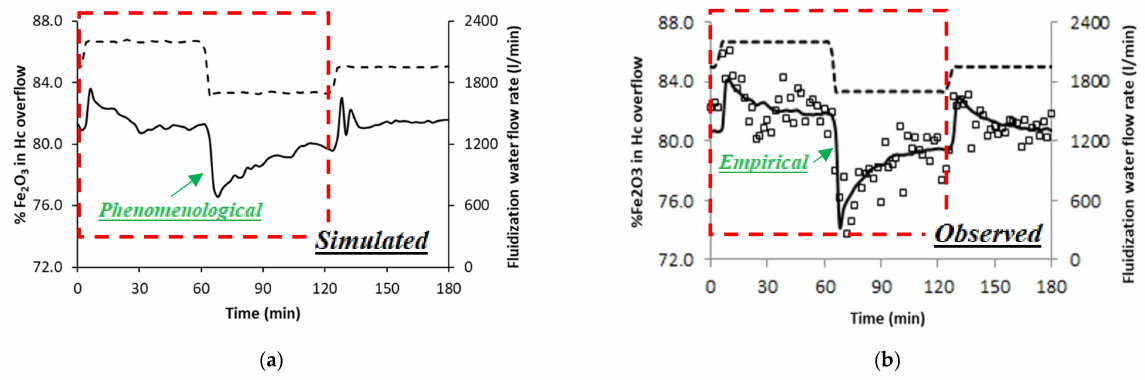
Figure 11. Recovery of Fe 2 O 3 in overflow as a function of teeter water for experiments 1 to 4: ( a ) simulated and ( b )